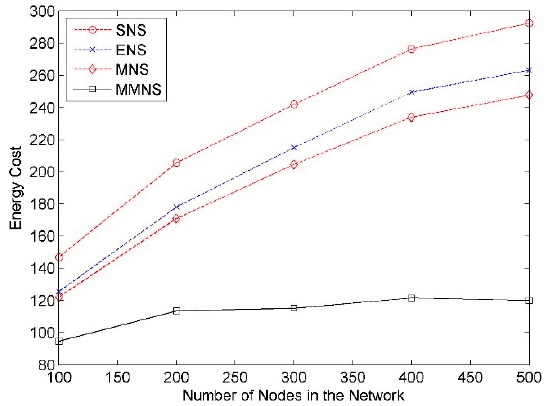
Figure 5. The impact of the network size on the energy cost.